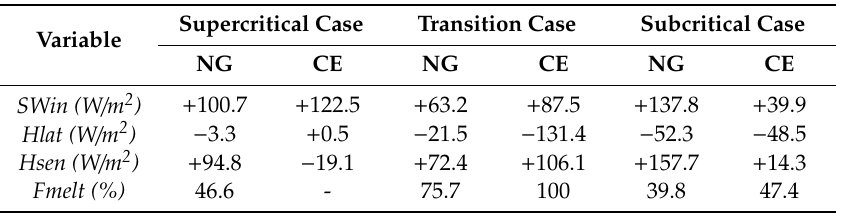
Table 5. Anomalies of incoming shortwave radiation ( SWin ), turbulent latent heat flux ( Hlat ) and turbulent sensible heat flux ( Hsen ) during föhn activity for supercritical, transition and subcritical cases at two locations. Anomalies compare the average during the peak of each föhn event to the average of all simulations. Fmelt gives the fraction of all melt hours that coincide with the respective föhn event for each simulation individually. Supercritical Variable